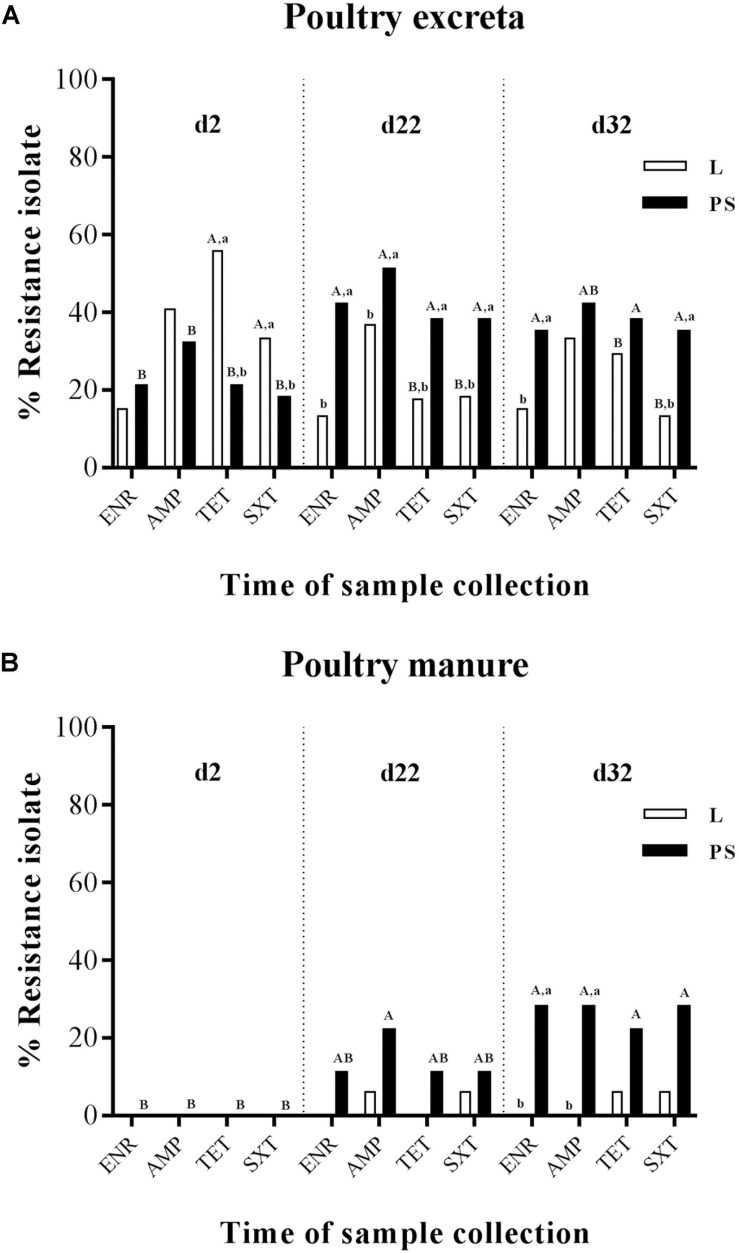
Percentage of frequency of antibiotic resistance of E. coli isolates obtained from excreta (A) and poultry manure samples (B) in different flooring designs [Litter (L) = entire floor stable covered with litter (wood shavings), Partial-slats (PS) = floor stable with litter and one-quarter slatted flooring] at three different sampling times. Relative frequency of resistance patterns exhibited by resistant isolates to four AB. Tested AB: enrofloxacin (ENR), ampicillin (AMP), tetracycline (TET) and trimethoprim/sulfamethoxazole (SXT) in commensal E. coli isolates. Excreta samples (N = 720; per group d2: n = 120, d22: n = 120, d32: n = 120) and poultry manure samples (N = 108; per group d2: n = 18, d22: n = 18, d32: n = 18). Flooring type: □ Litter group (L), ■ Partial-slats group (PS). Different lowercase letters (a, b) show significant differences in percentage of frequency of antibiotic resistance bacteria depending on flooring (L; PS), specific for time point, separated for each antibiotic (p < 0.05). Different upercase letters (A, B) show significant differences in percentage of frequency of antibiotic resistance bacteria depending on time point specific for flooring (L; PS), separated for each antibiotic (p < 0.05).